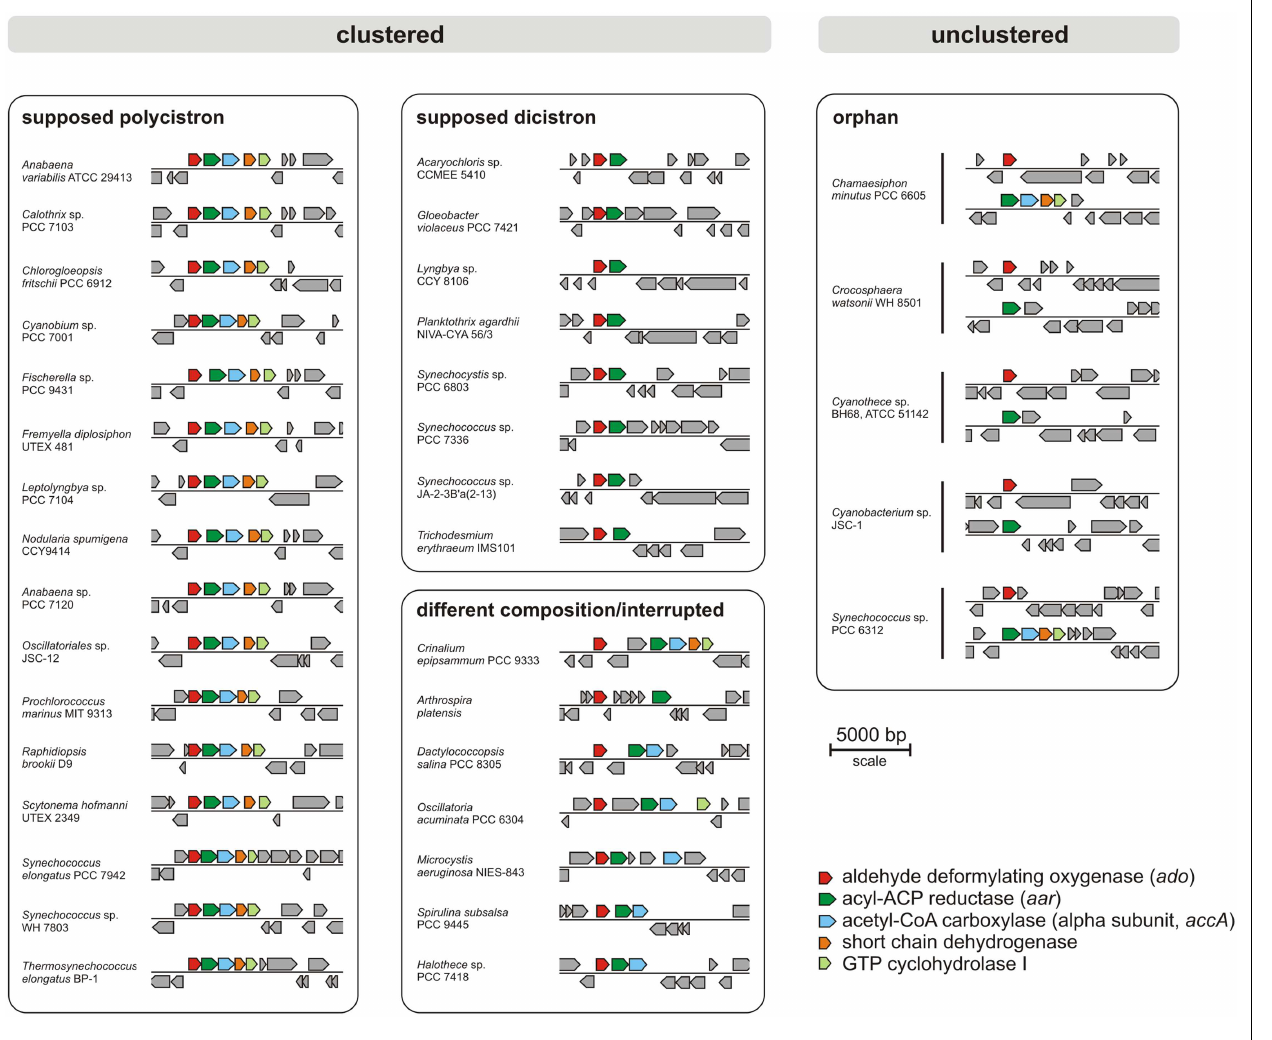
FIGURE 1 | Examples for genomic arrangements of aldehyde deformylating oxygenase orthologs in cyanobacteria . By using JGI database and blastP algorithm (threshold E -value = 1e − 5 ) 181 cyanobacterial